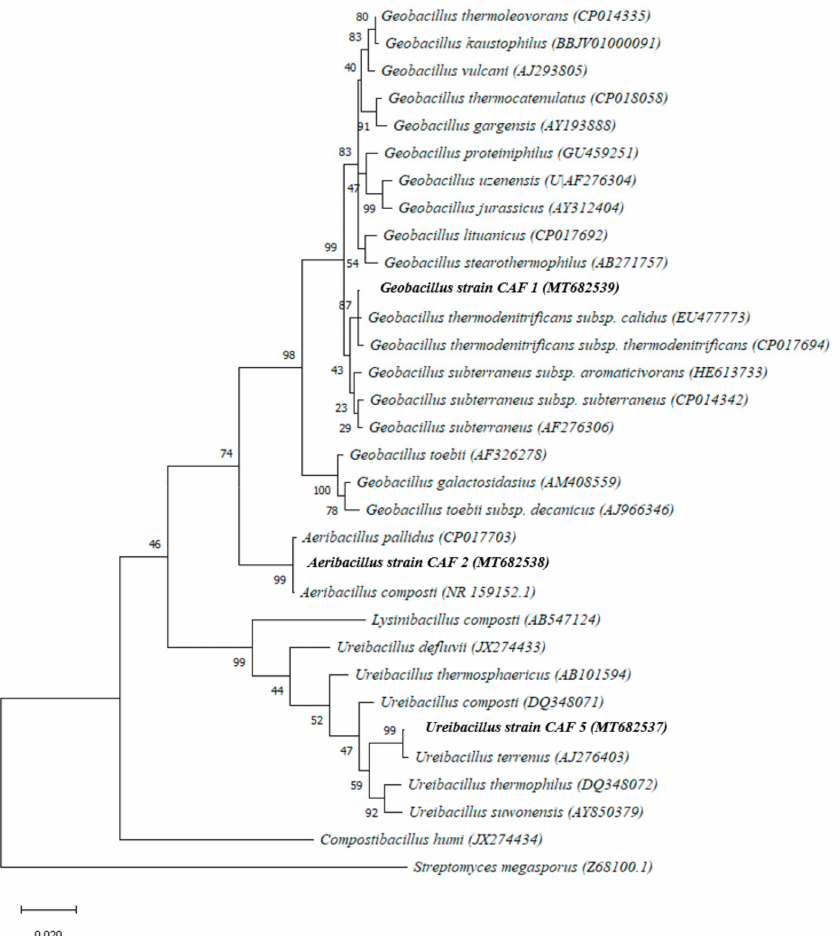
Figure 3. Evolutionary phylogenetic tree that was constructed using the maximum likelihood method showing the relationship between the strains CAF1, CAF2, and CAF5 and the related taxa. Bootstrap values based on 1000 replications are shown at nodes. The isolates obtained from this work are reported in bold. Numbers Streptomyces megasporus INA M-22T (Z68100) was used as an